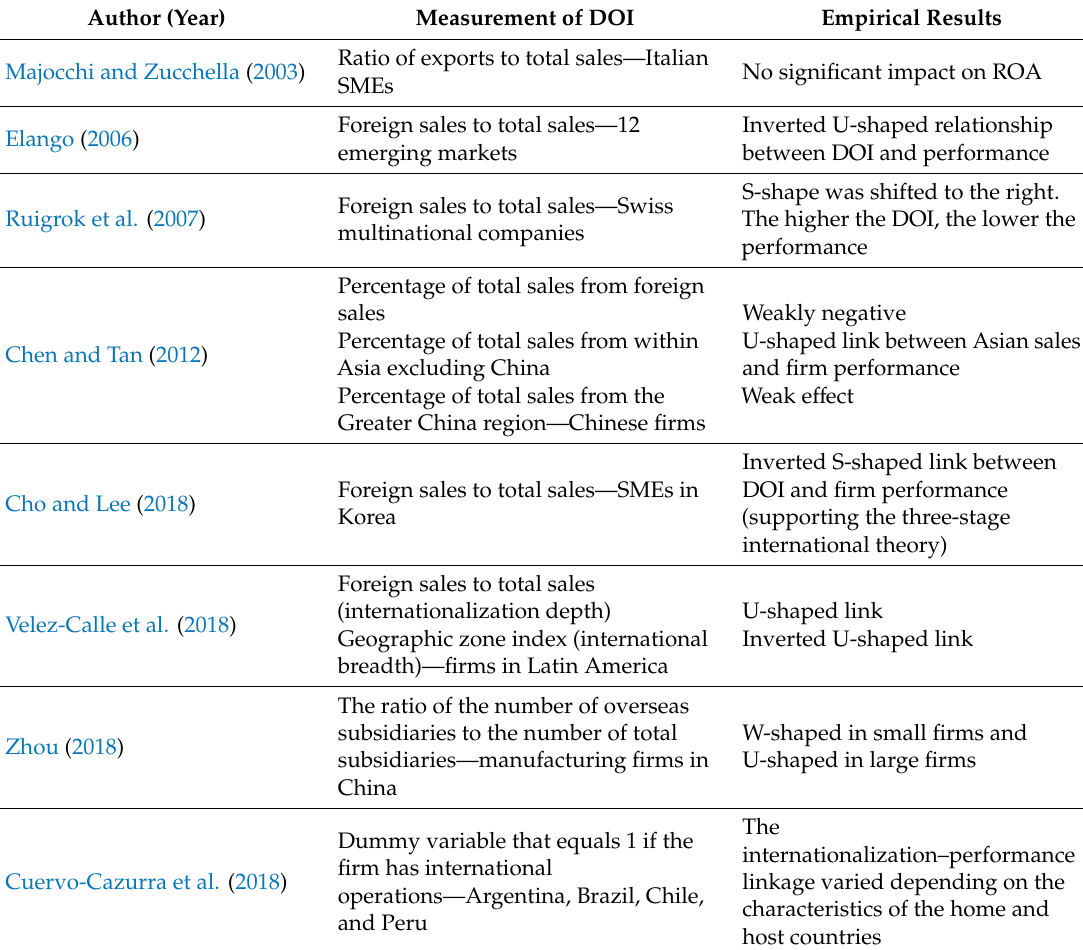
Table 1. Empirical studies on the internationalization–performance